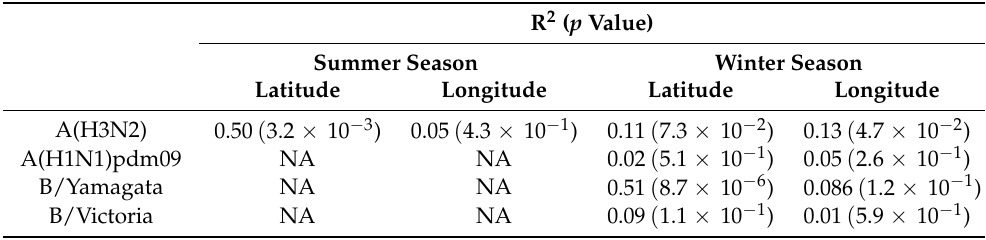
Table 2. Latitude and longitude gradient analysis for onset time of influenza A(H1N1) pdm09, A(H3N2), B/Yamagata, and B/Victoria in summer and winter seasons,